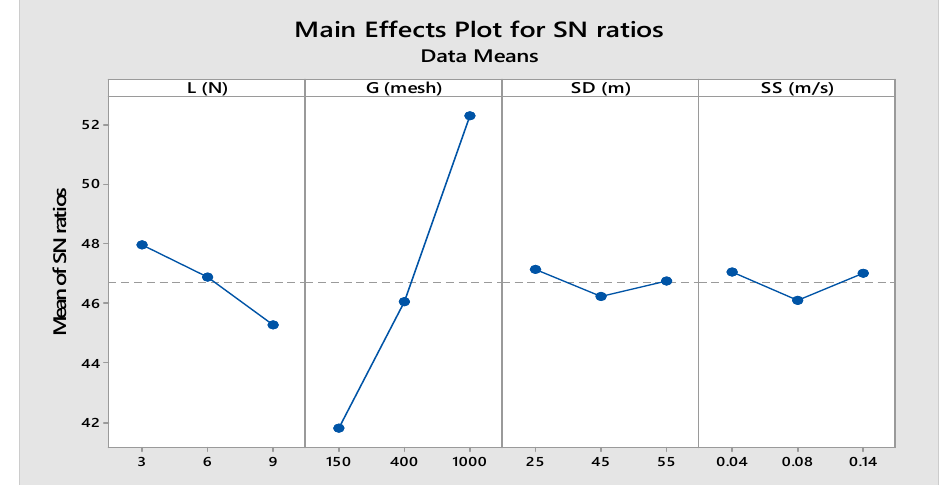
Figure 11. Main effect plot for SNRs of mean M L .